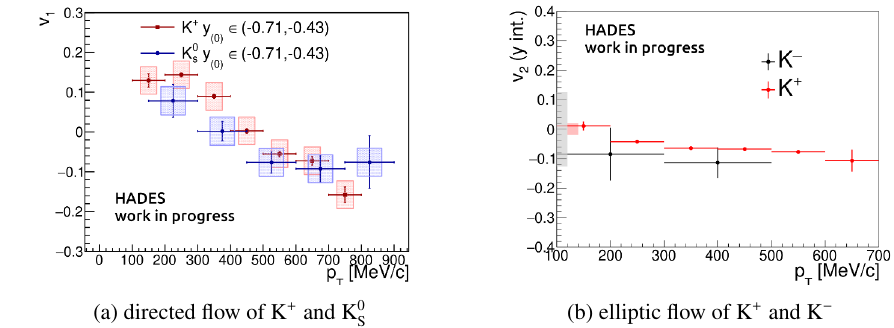
Figure 1: Comparison of transverse flow for di ff erent kaon’s charges.